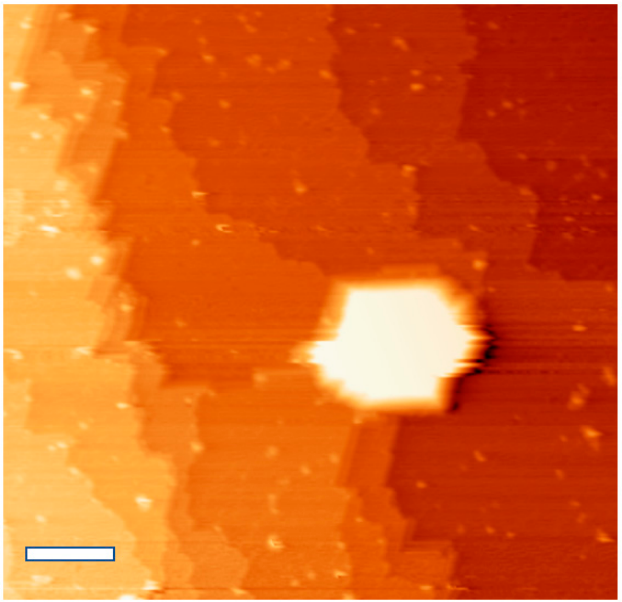
Figure 5. STM topographical image of a bare Ge (110) sample with 18 cleaning cycles, fluence 3.5 × 10 17 cm − 2 , performed in a Ag-coated sample holder using 200 eV Ar + ions. Imaging parameters 0.5 nA, 2 V tip bias. The contrast is enhanced to show the step edges, making the central pyramid appear to be saturated in brightness. Scale bar: 50 nm.